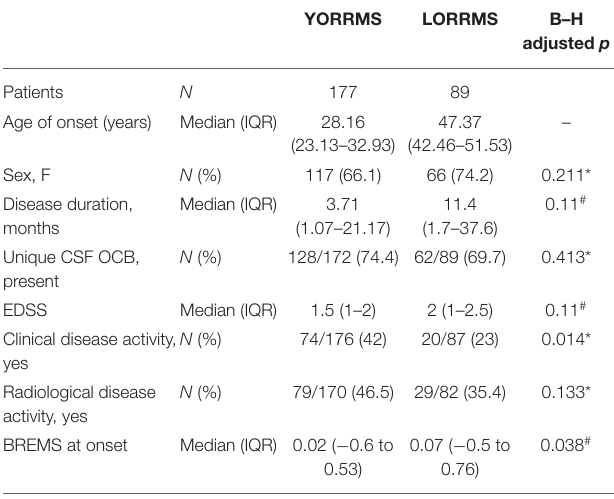
TABLE 3 | Clinical characteristics of young-onset and late-onset patients with RR-MS.